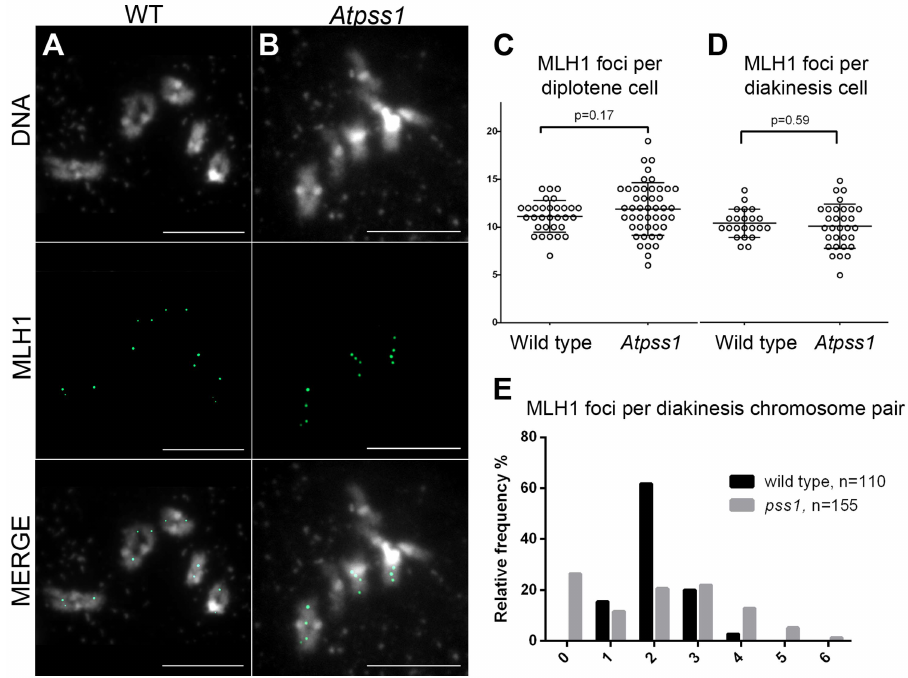
Figure 5. MLH1 immunolocalization. Immunolocalization of MLH1 at diakinesis is shown (A) in wild type and (B) in Atpss1-1 . (C, D). Scatter plot of MLH1 foci number per cell at diplotene and diakinesis. (E) Distribution of chromosomes according to their MLH1 foci number at diakinesis. Cells